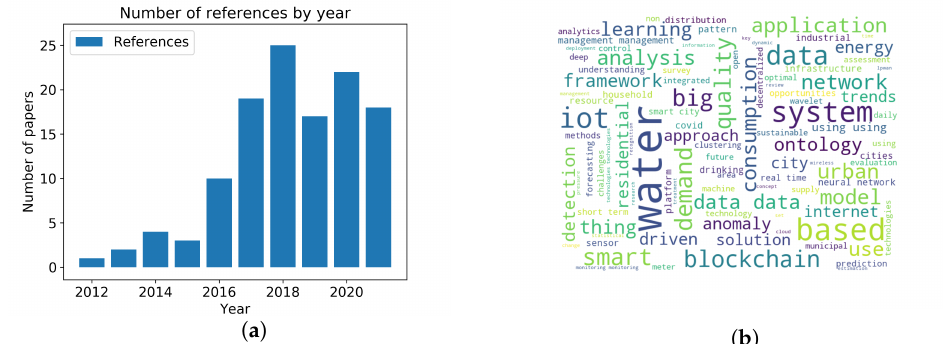
Figure 2. Evaluation of referenced papers. ( a ) Number of referenced papers by year. ( b ) Word cloud from referenced paper